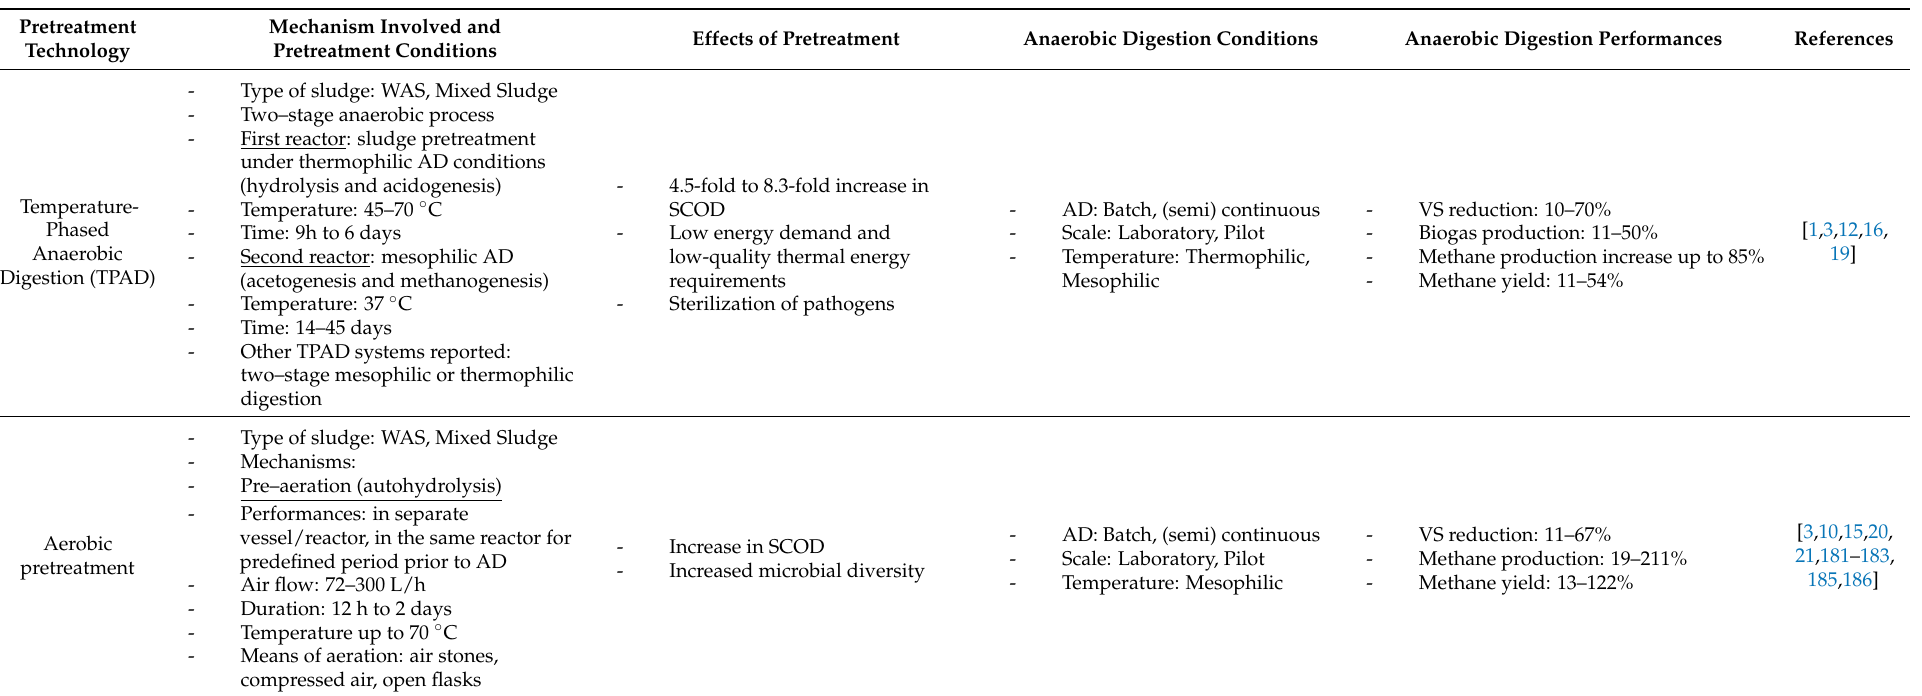
Table 4. Effects of biological pretreatment methods on anaerobic